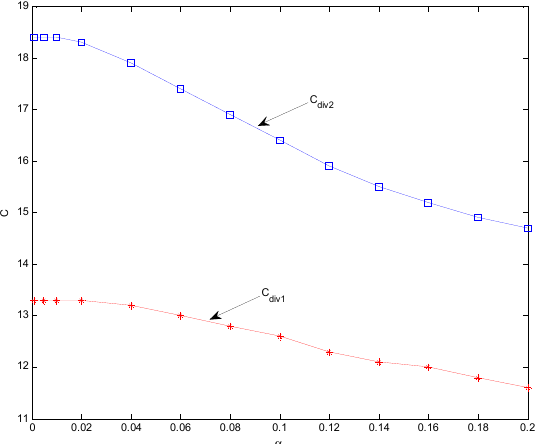
Figure 10. Effect of the small-parameter α on dimensionless complex frequencies of the axially-moving nanoplate resting on a viscoelastic foundation.